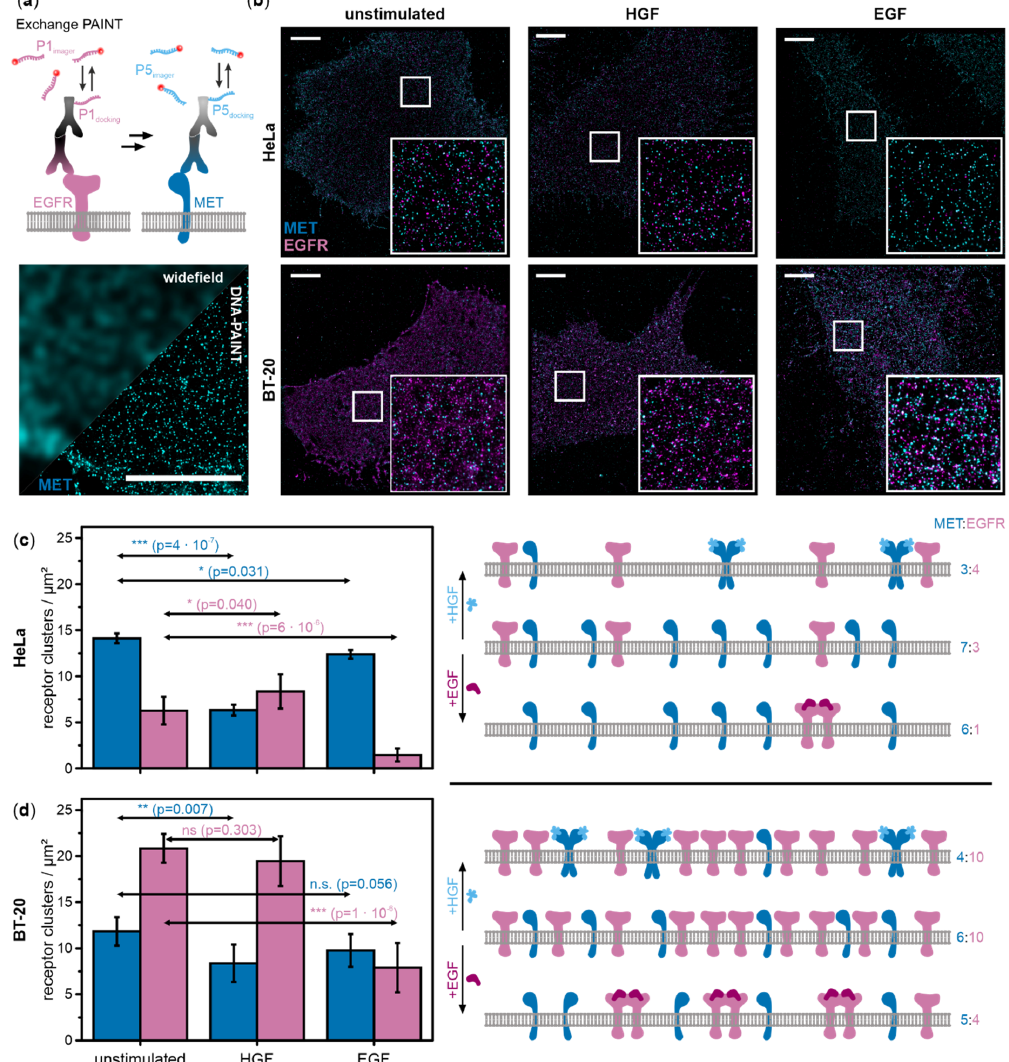
Figure 1. MET and epidermal growth factor receptor (EGFR) densities in the cell membrane of HeLa and BT-20 cells. ( a ) Concept of super-resolution microscopy by Exchange-PAINT of MET and EGFR (top). A super-resolved image is obtained from transient binding events of short, fluorescently labeled DNA oligonucleotides to DNA-labeled antibodies. The image (bottom) shows MET visualized by widefield microscopy versus DNA-PAINT (scale bar 5 µm). ( b ) Exchange-PAINT images of MET (cyan) and EGFR (magenta) immunostained with secondary antibodies carrying P5 and P1 DNA docking strands and labeled with complementary DNA imager strands labeled with ATTO 655. Total internal reflection fluorescence (TIRF) images of the plasma membrane of HeLa and BT-20 cells were recorded either in the unstimulated state, after hepatocycte growth factor (HGF) stimulation, or after activation with epidermal growth factor (EGF) (scale bar 5 µm, insets 5 µm × 5 µm). Receptor cluster densities of MET (cyan) and EGFR (magenta) in ( c ) HeLa and ( d ) BT-20 cells were determined from DNA-PAINT images ( n = 6–7 cells/condition from at least three independent experiments) and plotted in the histogram (left). (Note that receptor clusters refer to both monomers and dimers.) Error bars represent standard deviations. Results of two-sample t-tests for comparison of activated samples with the respective unstimulated sample are depicted as arrows ( p > 0.05 no significant difference between populations (n.s.), p < 0.05 significant difference (*), p < 0.01 very significant difference (**), p < 0.001 highly significant di ff erence (***)). The quantitative data was used to generate density and activation schemes of MET and EGFR in HeLa and BT-20 (numbers at the right indicate relative receptor ratios at the cell membrane determined from DNA-PAINT